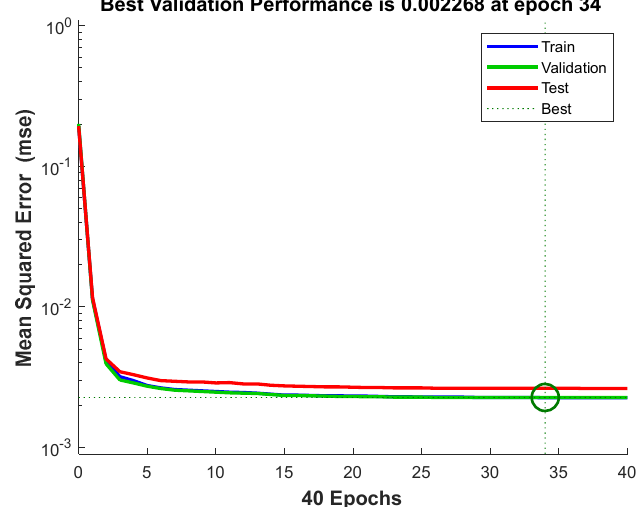
Figure 6 . NN learning generalization trajectory.